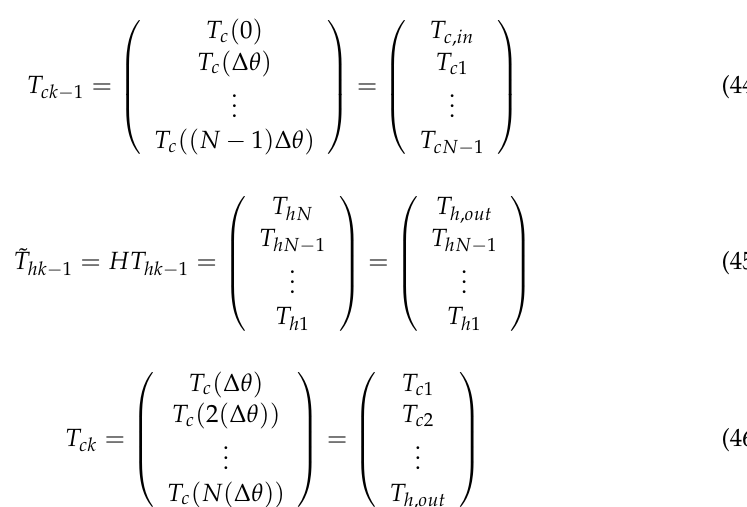
In Figure 5, ˜ T hk − 1 and T ck − 1 is parallel input data, respectively. T ck is a parallel output data.